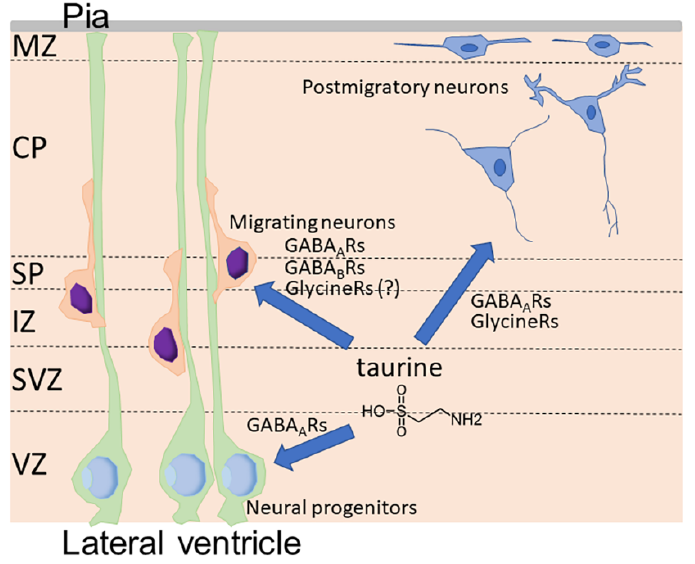
Figure 2. Functions of taurine as endogenous agonists for GABA A receptors (GABA A Rs), GABA B receptors (GABA B Rs), and glycine receptors (Glycine Rs) in the developing cortex. CP, cortical plate; IZ, intermediate zone; MZ, marginal zone; Pia, pia mater; SP, subplate; SVZ, subventricular zone; VZ, ventricular zone.